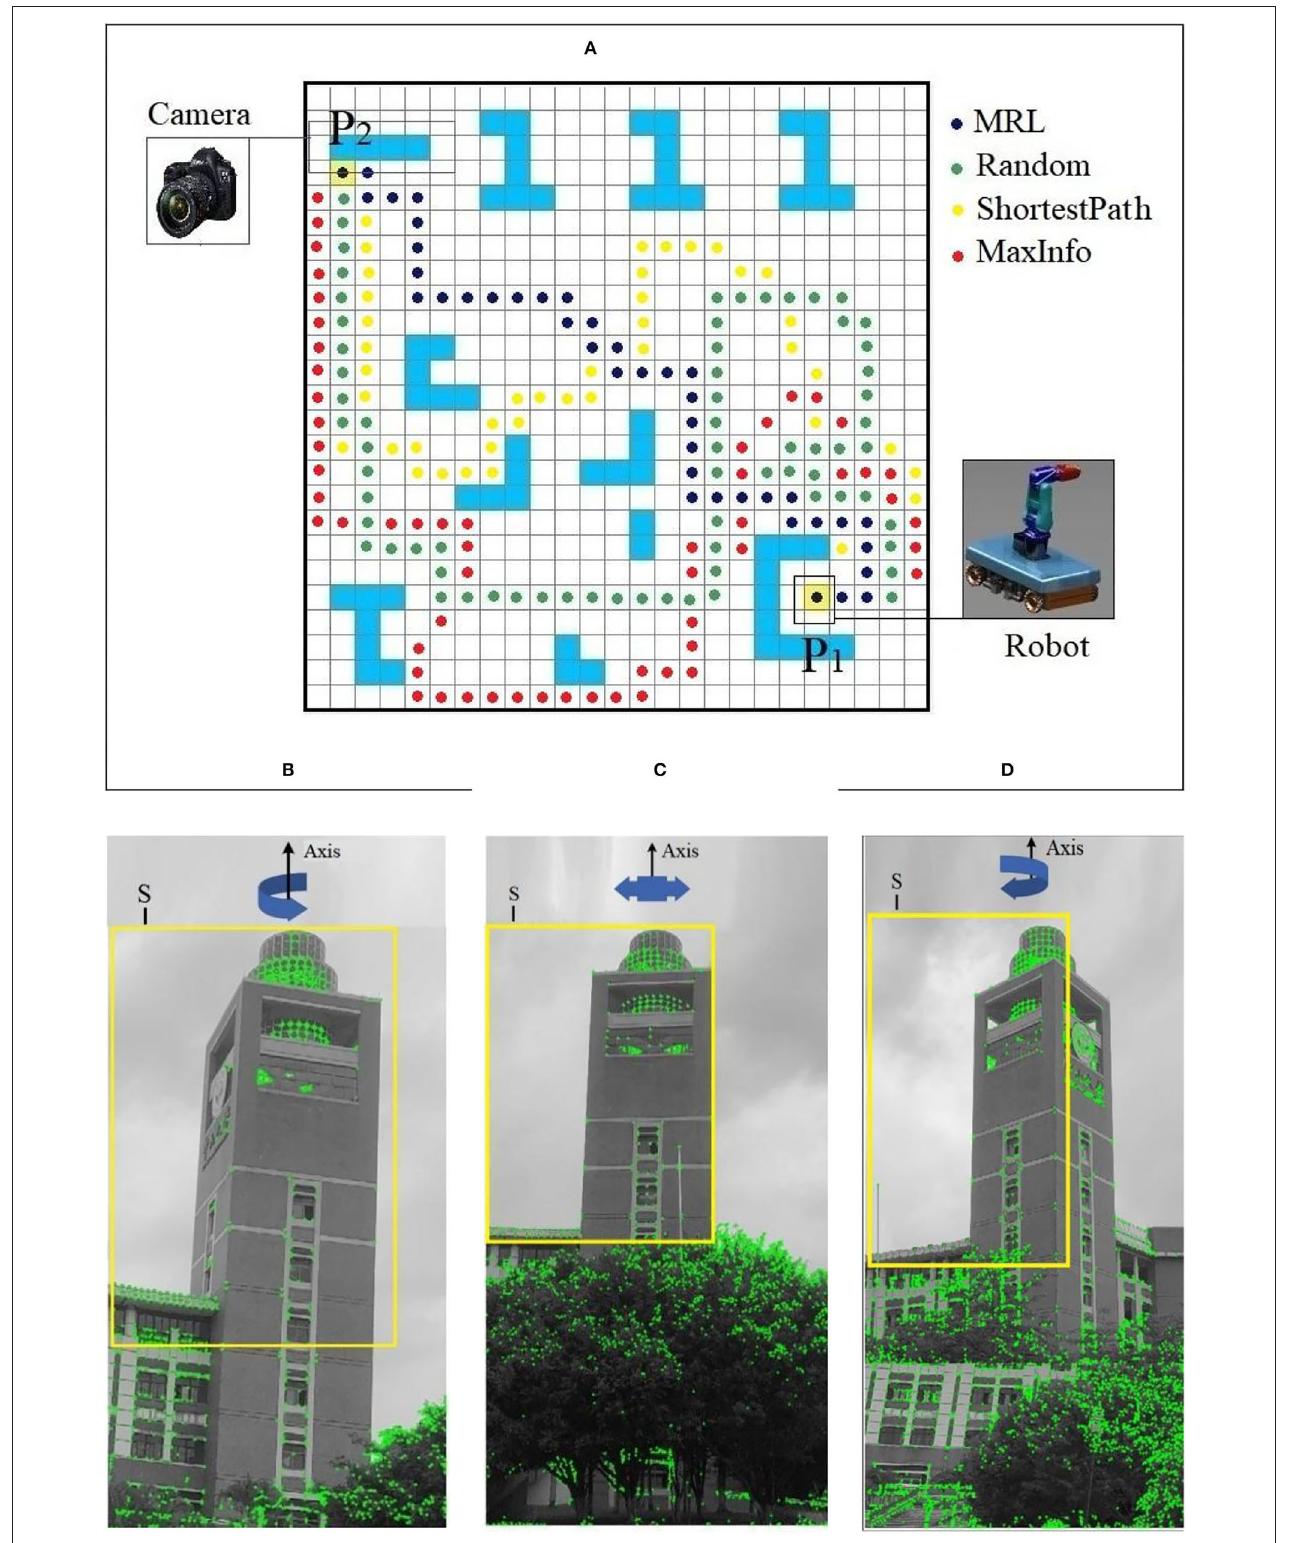
FIGURE 6 | Result of MRL and shooting angle for building safety assessment. (A) Comparison of path planning algorithms. (B) Shooting angle axis is offset to the left. (C) Shooting angle axis is symmetrical. (D) Shooting angle axis is offset to the right.